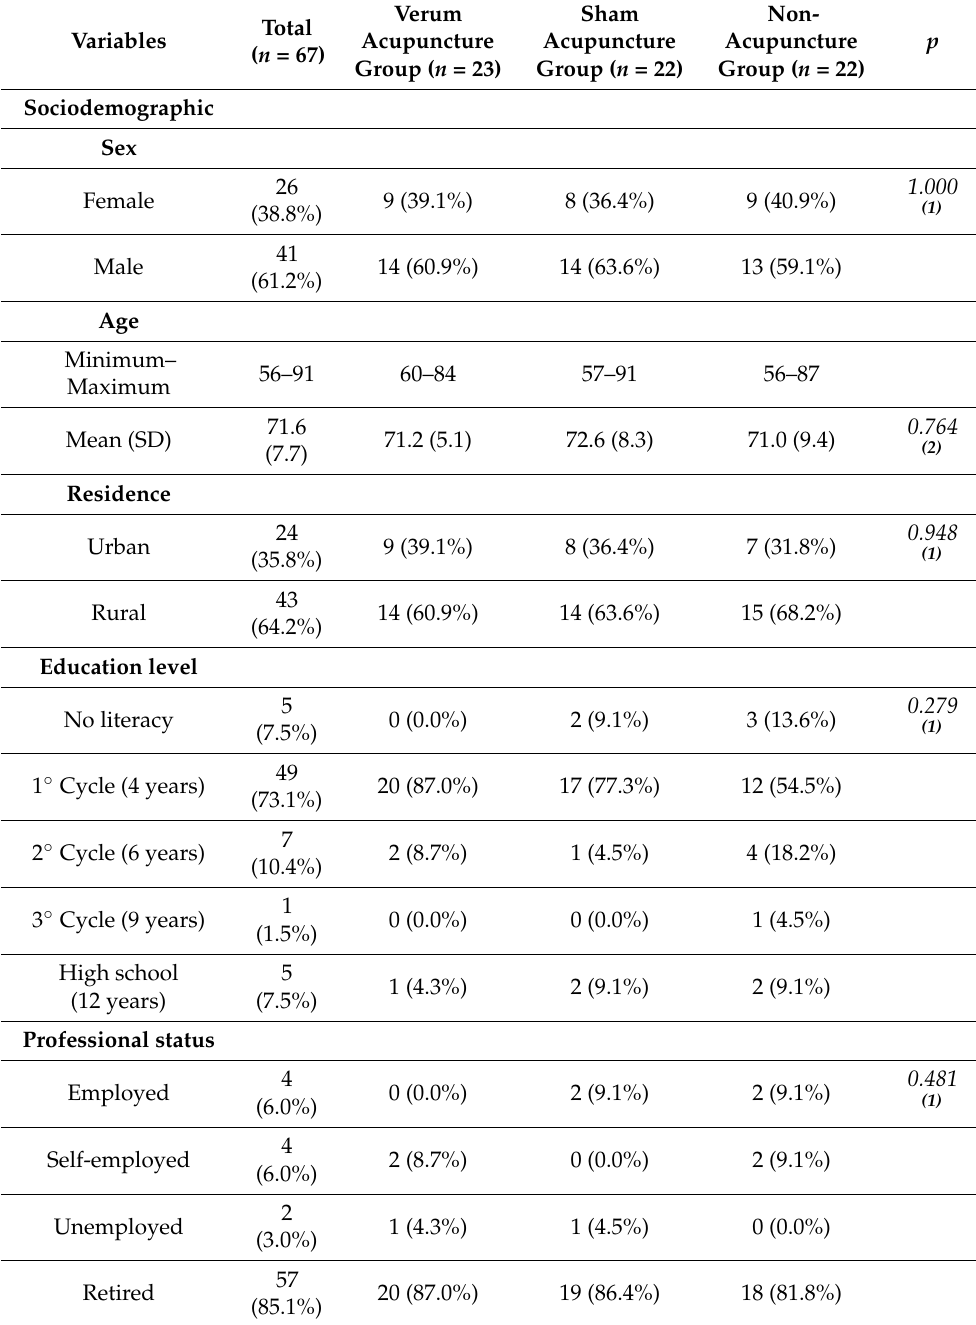
Table 2. Sociodemographic, clinical and laboratorial characteristics of the sample, overall and by group